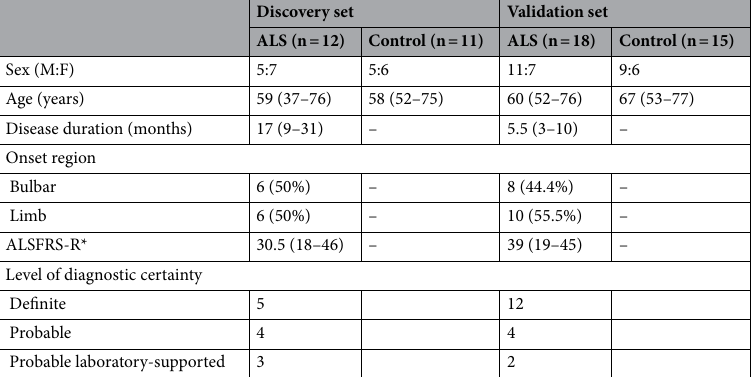
Discovery set Validation